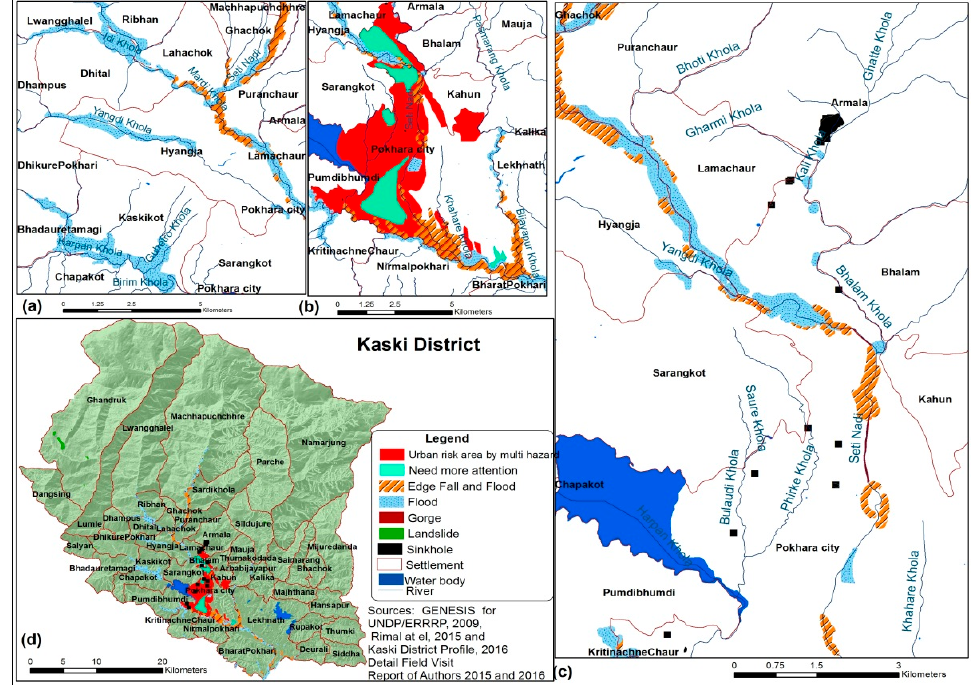
Figure 6 . Multihazard risk map of the study area: ( a ) major flood area; ( b ) multihazard risk urban areas; ( c ) flood and edge fall and sinkhole risk areas; and ( d ) overlay of multiple hazards in district map.